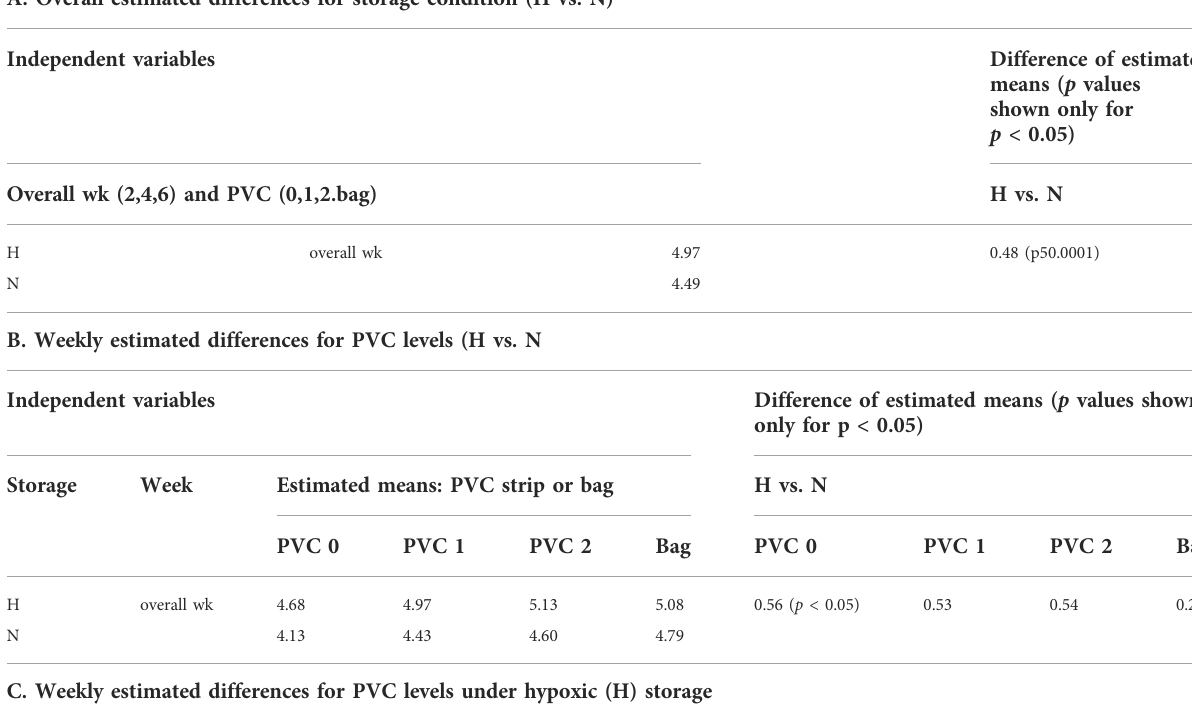
means ( p values shown only for p < 0.05)